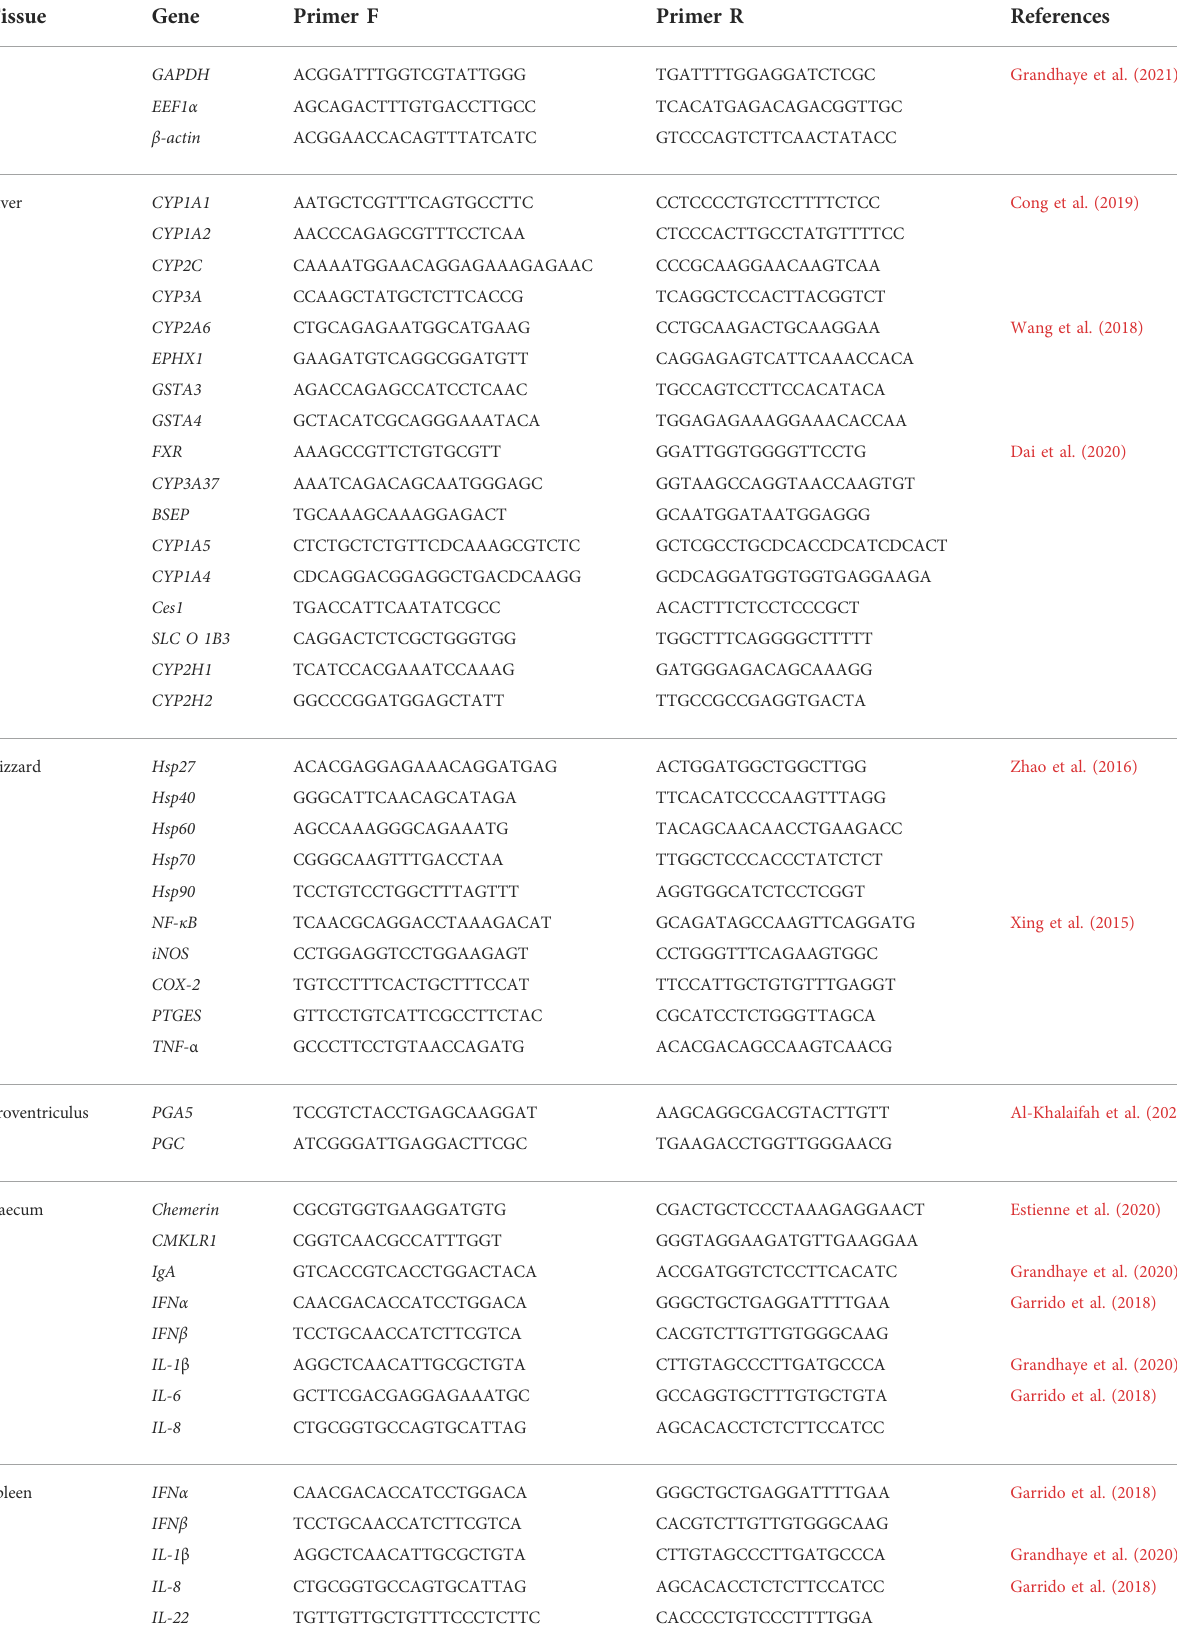
TABLE 1 Oligonucleotide primer sequences used for RT-qPCR.